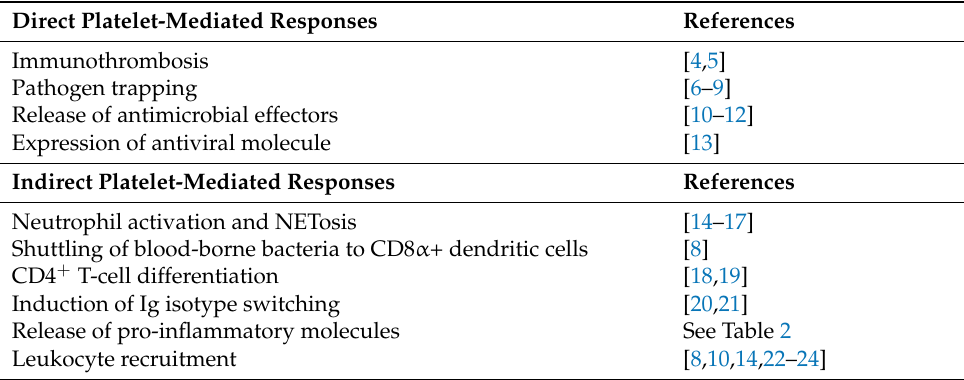
Table 1. Platelet-mediated responses in infection. Direct Platelet-Mediated Responses